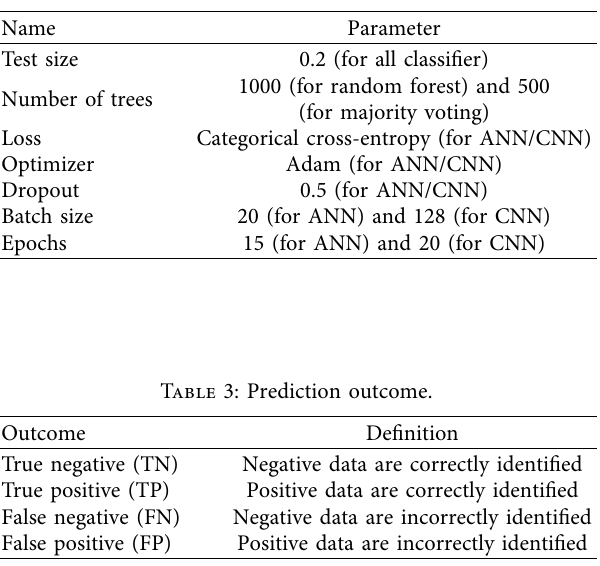
Table 2: Parameters details.